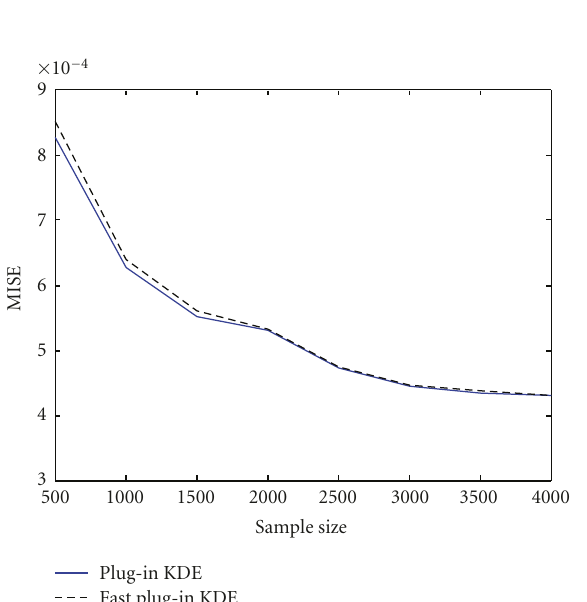
Figure 3: MISE estimated by plug-in optimal KDE and fast plug-in optimal KDE (power 4.5) versus the sample size.